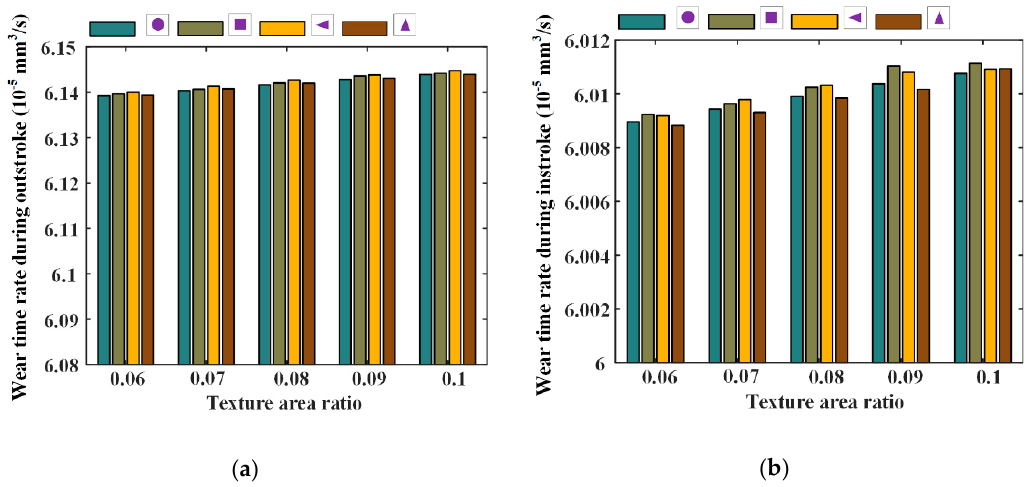
Figure 20. The relationship between wear time rate and texture area ratio, ( a ) outstroke, ( b ) instroke.